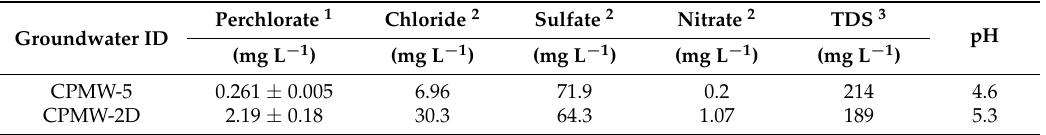
Table 1. Composition of anions making up the groundwater samples whose SERS spectra are shown in Figure 13b, Reproduced with permission from John Wiley and Sons, 2017